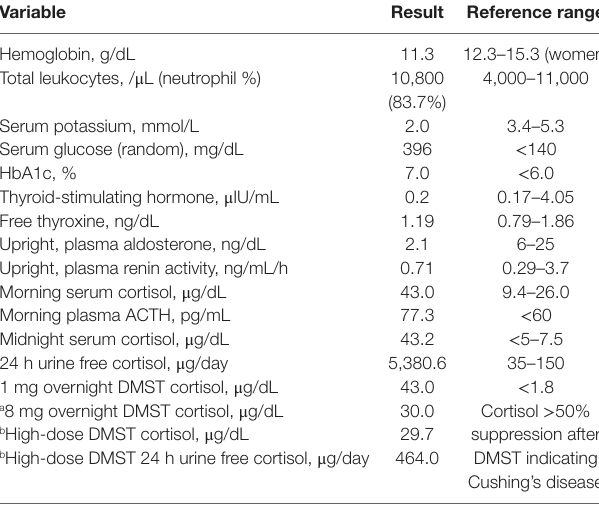
table 1 | Results of laboratory